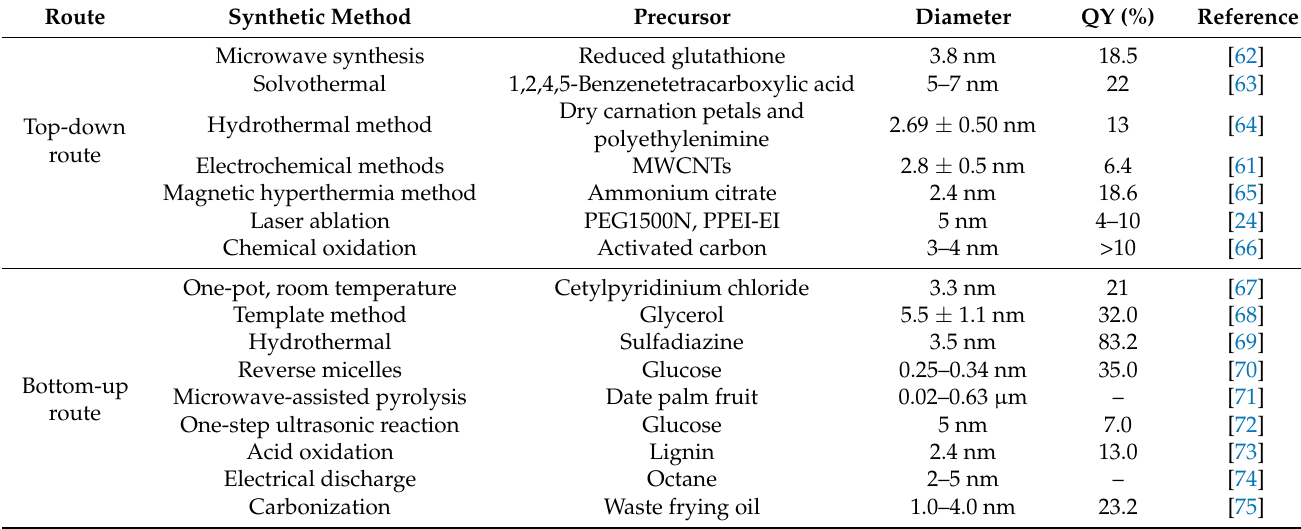
Table 1. Typical synthetic methods and properties of